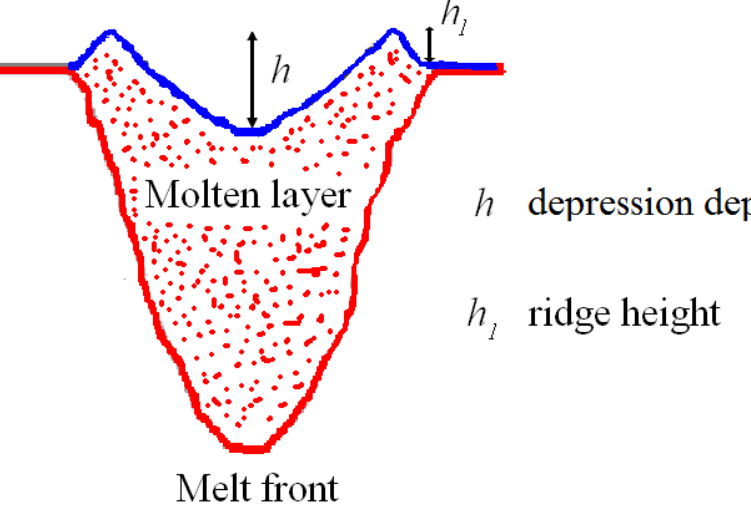
Figure 11. Schematic section of the zone affected by laser pulse.